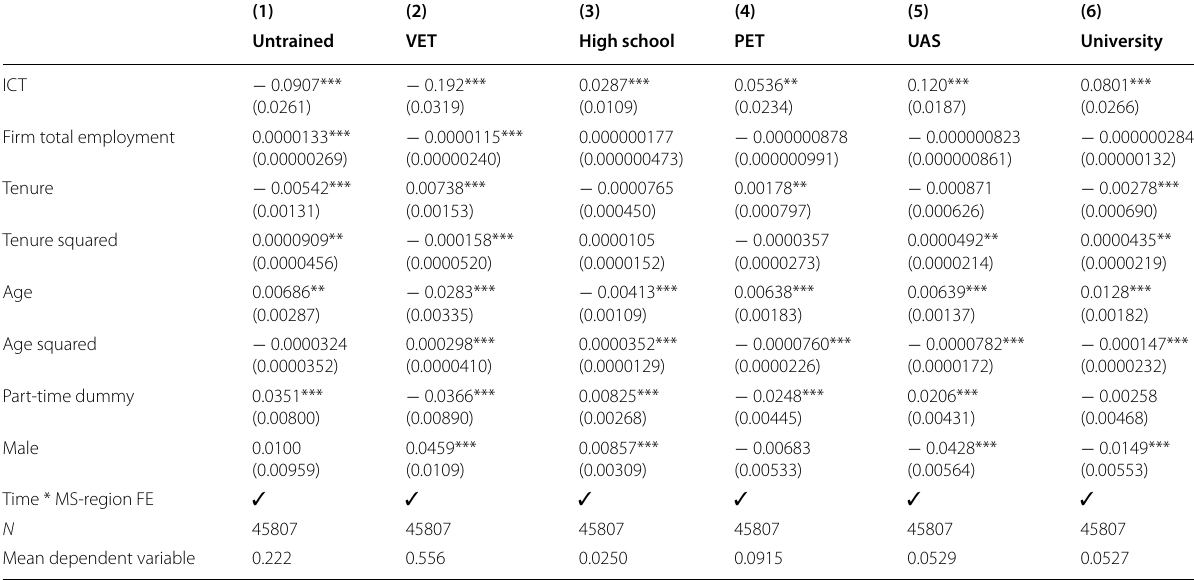
The table shows OLS coefficients of fixed effects estimates of a firm pseudo-panel with cells defined based on MS-region, industry, and firm size. Standard errors in parentheses are clustered at the cell level. N reports the number of pseudo-panel cells that contain at least one firm. The main explanatory variable measures the cell